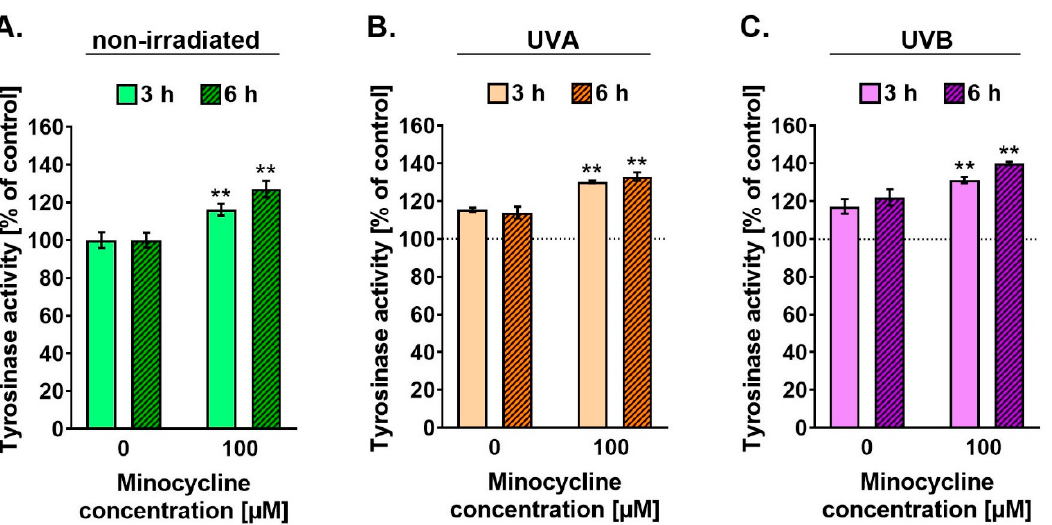
Figure 6. Minocycline causes an increase in the activity of tyrosinase in melanocytes ( A ) non-irradiated ( B ) exposed to UVA radiation ( C ) exposed to UVB radiation. The values for tyrosinase activity were normalized using total protein concentration. The results are presented as the percentage of control. ** p <